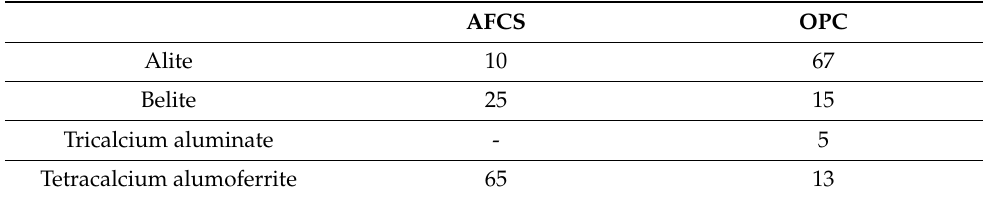
Table 2. Mineralogical composition of the hardening additive and cement.